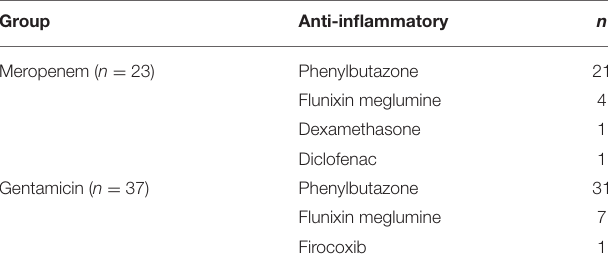
TABLE 7 | Concurrently administered anti-inflammatories for horses administered either meropenem or gentamicin via intravenous regional limb perfusion (IVRLP).